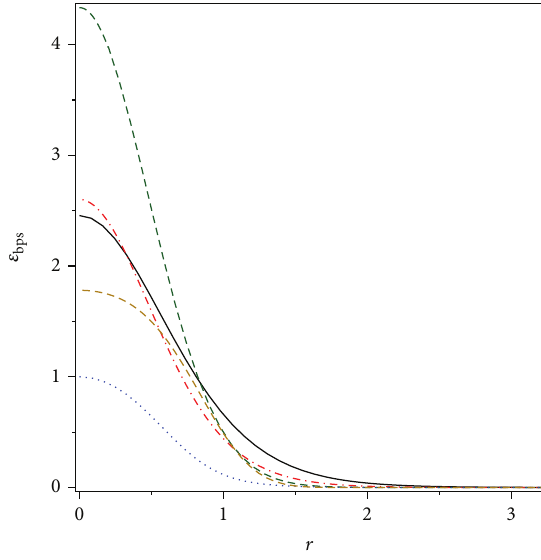
. Conventions as in Figure 1. bps